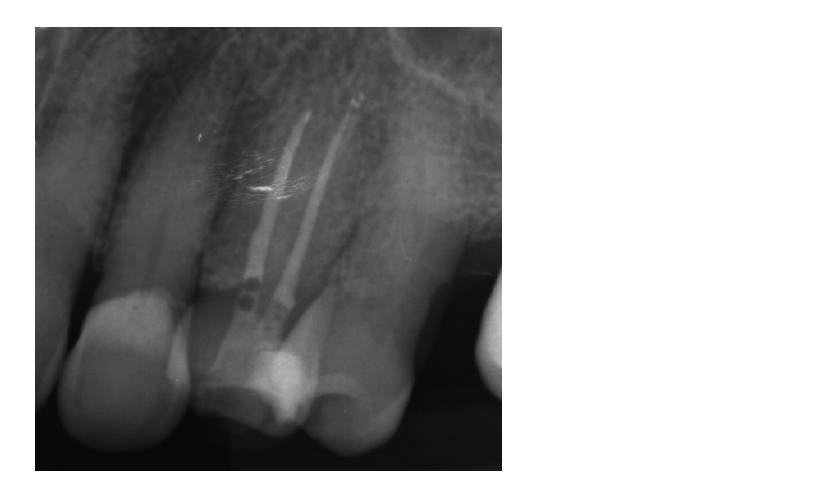
Figure 28. X-ray image showing the correctness of the performed root canal treatment.